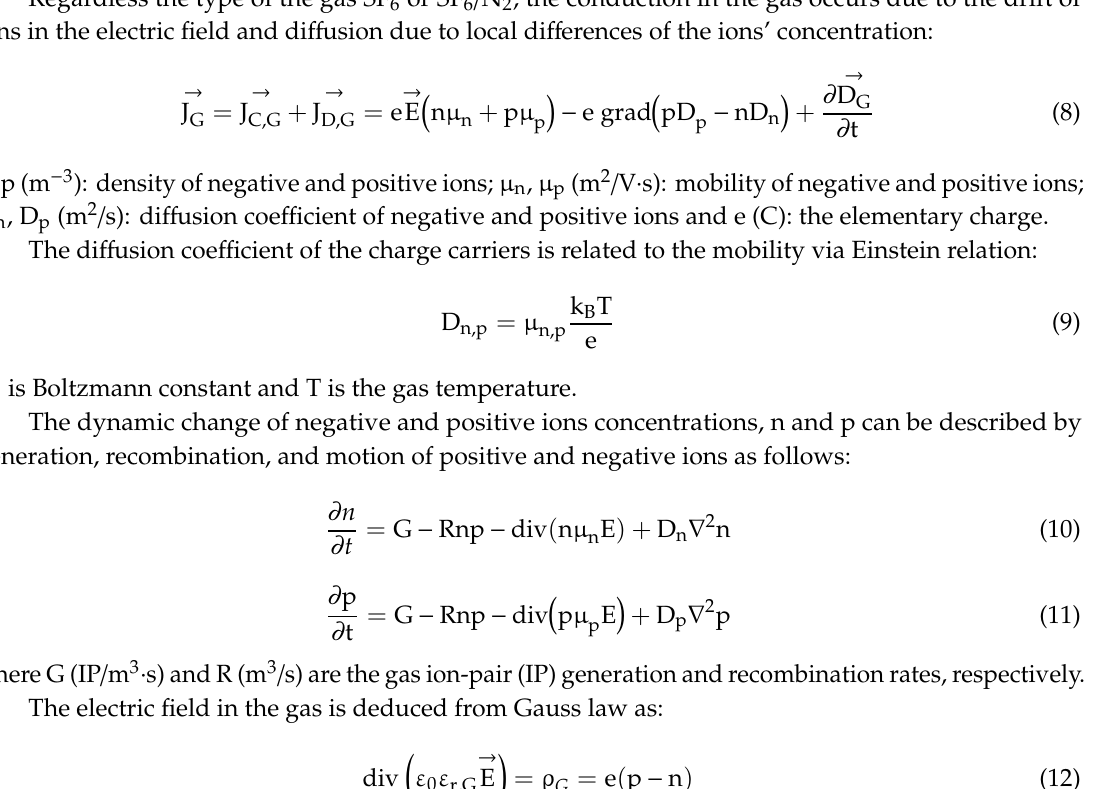
Figure 2. Relevant physical mechanisms occurring in the insulation of DC GIS / GIL systems [33].